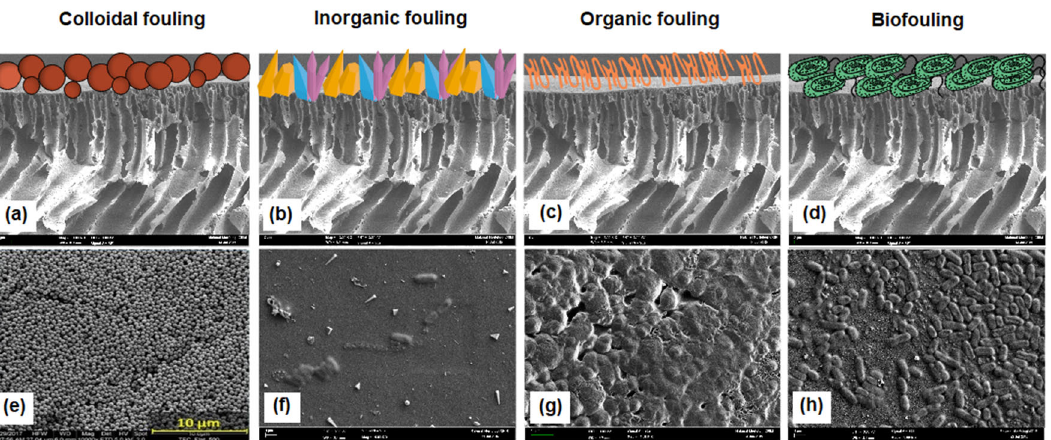
Figure 1. The schematic ( a – d ) and real membrane surface images ( e – h ) of different types of fouling (image ( e ) adapted from ref [32]).